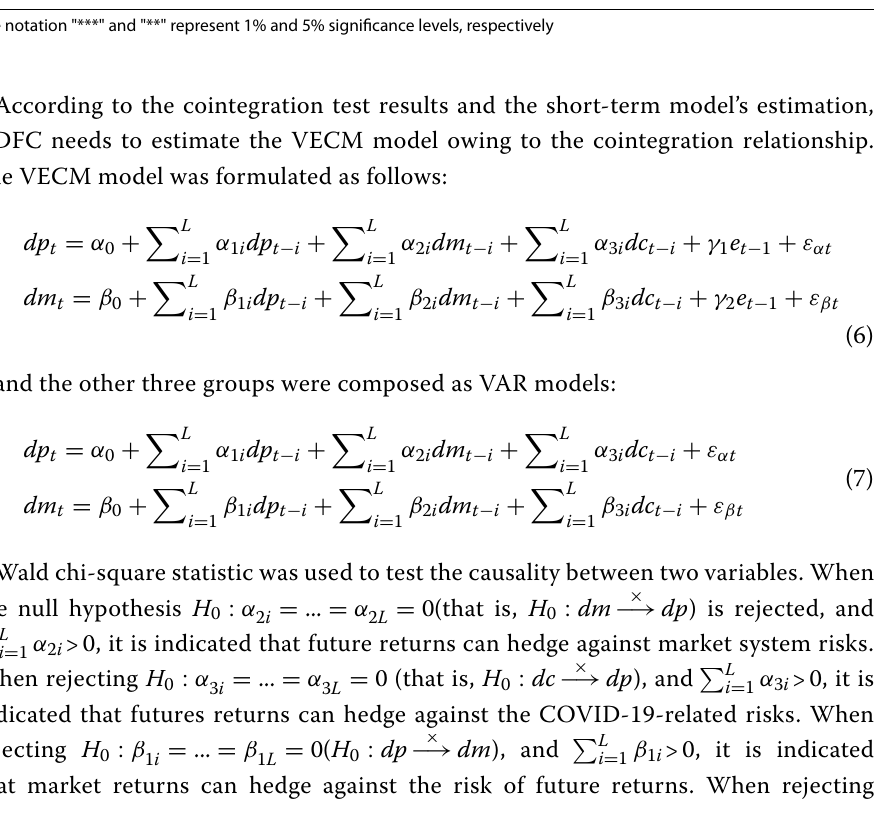
The notation "***" and "**" represent 1% and 5% significance levels, respectively